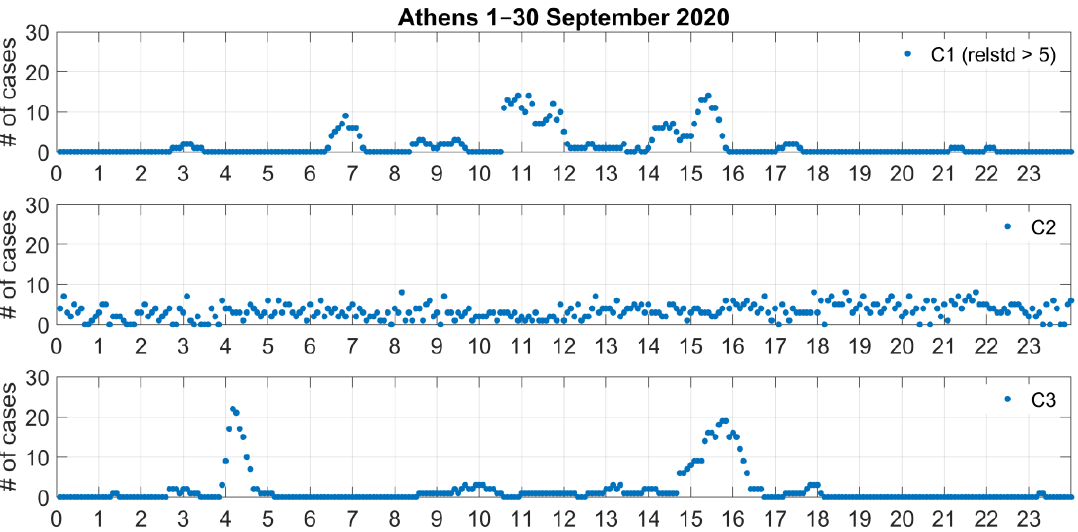
Figure 17. The number of cases in which each criterion is met in each hour of the day (summed over September